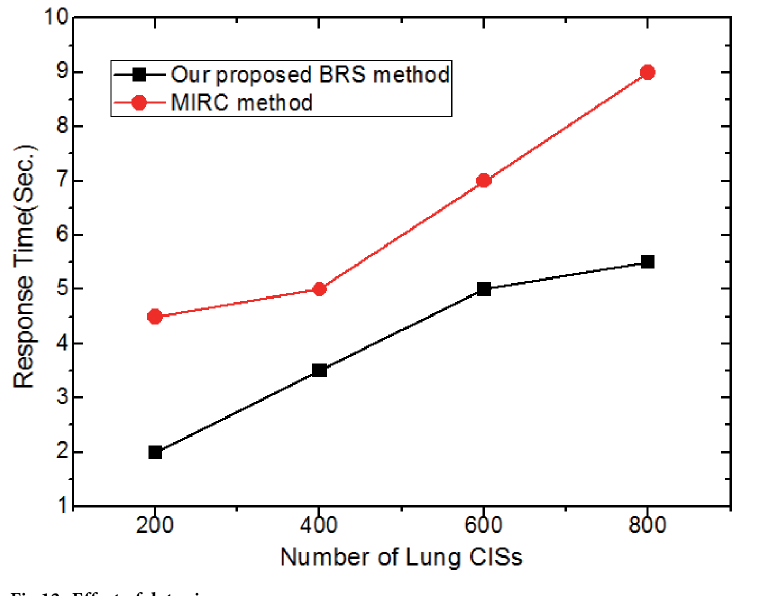
Fig 12. Effect of data size.